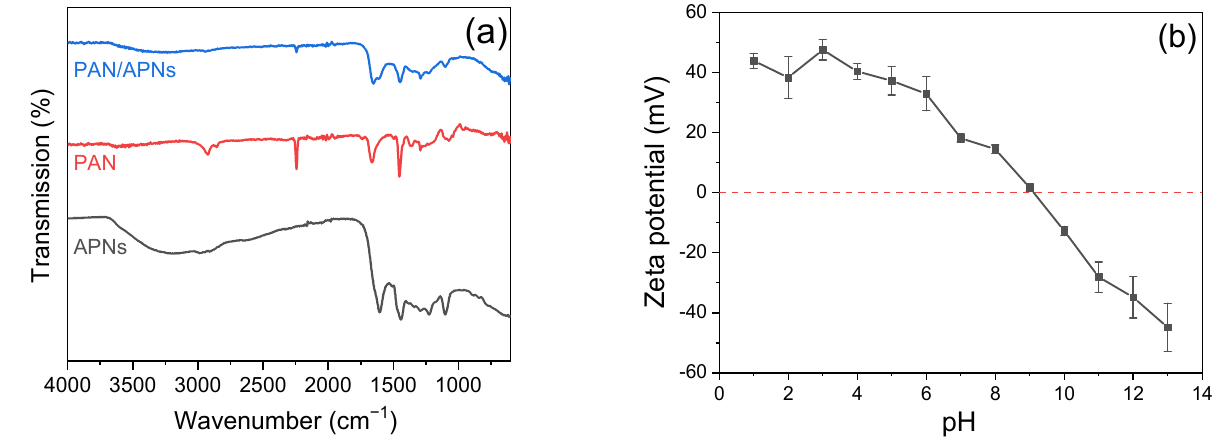
Figure 2. FTIR spectra of APNs, PAN and PAN/APNs ( a ) and zeta potential of APNs ( b ).